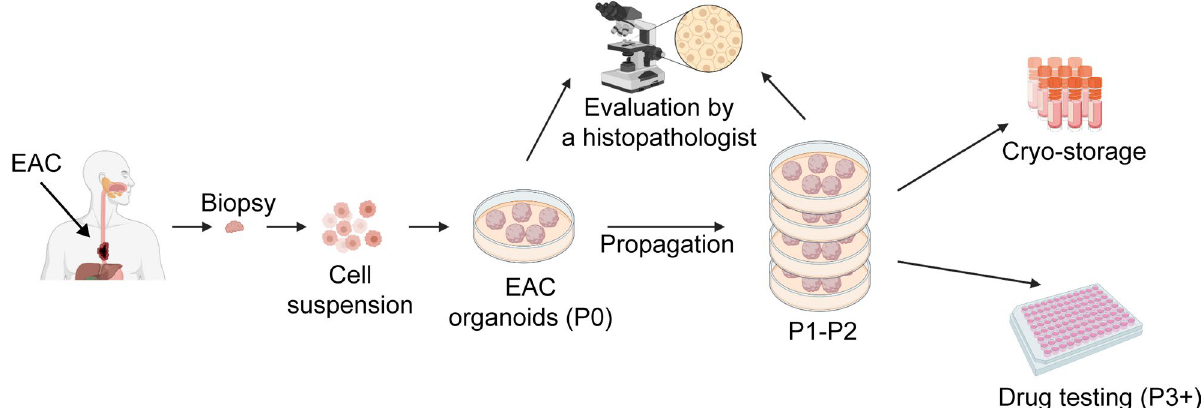
Figure 1. Schematic for EAC PDO generation. Diagnostic biopsies are enzymatically and mechanically dissociated into a single cell suspension, which is embedded in a basement membrane extract drop and grown in specialized culture medium. The PDOs are characterized by a pathologist to confirm EAC histology. Once sufficiently expanded and cryopreserved, the lines can be used for drug screening assays. Created with BioRender.com.